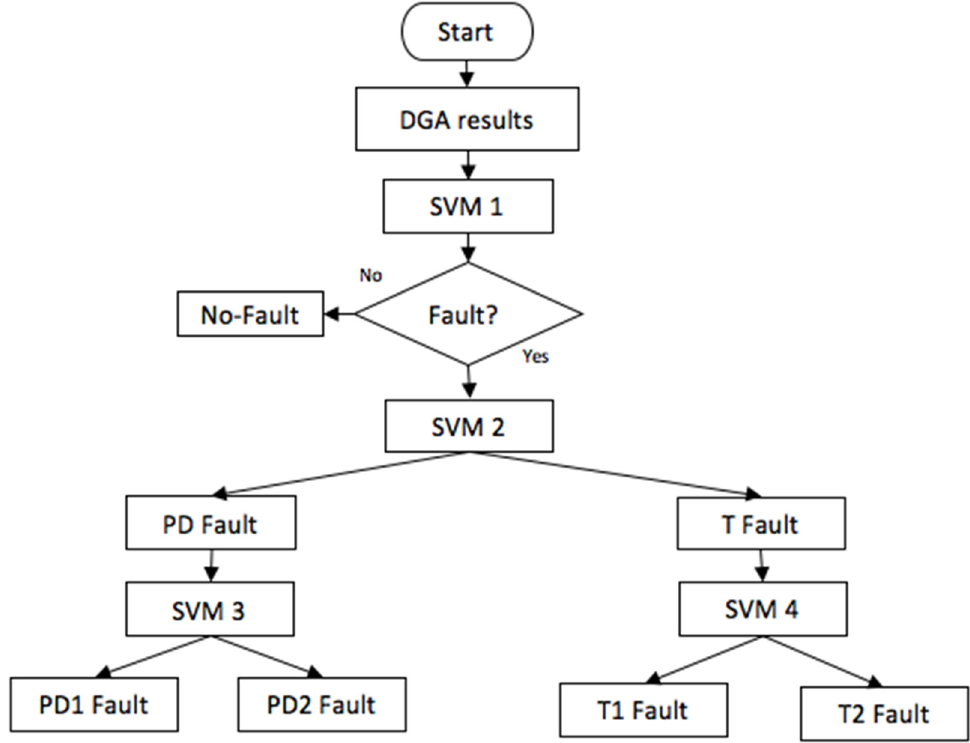
Figure 3. Proposed BCSVM classification tree.